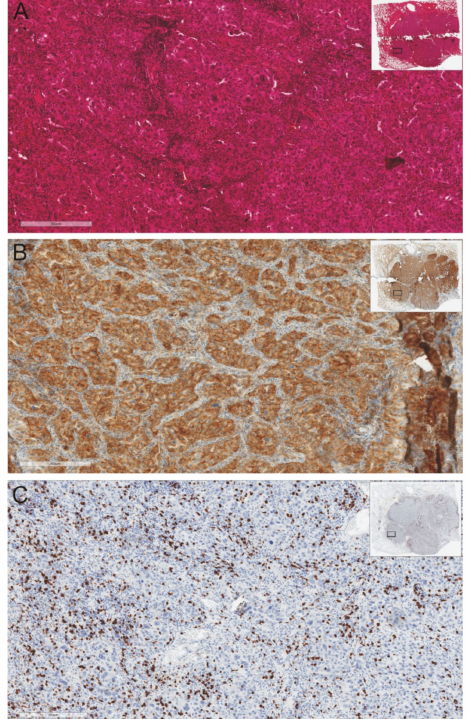
Figure 2. A case illustration of lung adenocarcinoma tissue with strong infiltration of CD8-positive lymphocytes and high expression of PD-L1 on tumor cells: ( A ). hematoxylin/eosine staining; ( B ). PD-L1 expression; ( C ). CD8 expression. Immunohistochemical staining was performed on authors’ own